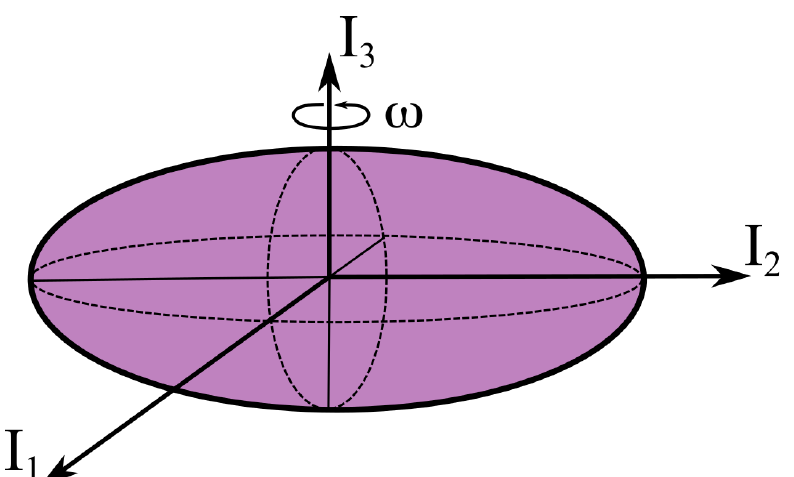
Figure 4. Simplest NS CGW model: non-axisymmetric, rotating NS (described as a triaxial ellipsoid) radiating gravitational waves at twice the spin